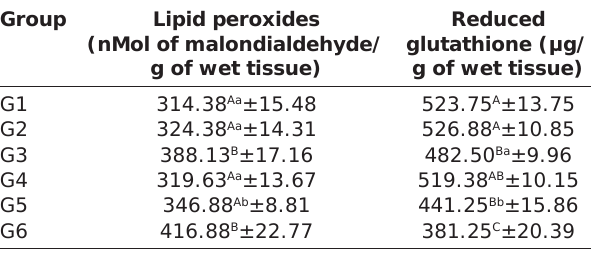
Table-3: Mean values of lipid peroxides (nMol of malondialdehyde/g of wet tissue) and reduced glutathione ( μ g/g of wet tissue) of rats administered with fresh juice and ethanolic extract of F. tsiela Roxb. Reduced Group Lipid peroxides glutathione ( μ (nMol of malondialdehyde/ g of wet tissue)